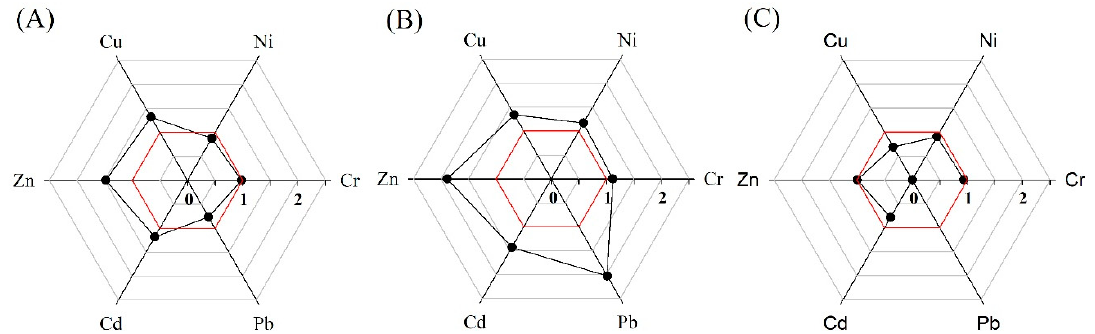
Figure 4. Trophic Magnification Factor (TMF) of the filter-feeding bivalves for the six studied metals including Zn, Cu, Ni, Cr, Pb and Cd in the three study sites, ( A ) WZW, ( B ) WG and ( C ) JZC, along Danshuei Riverine Mangrove.